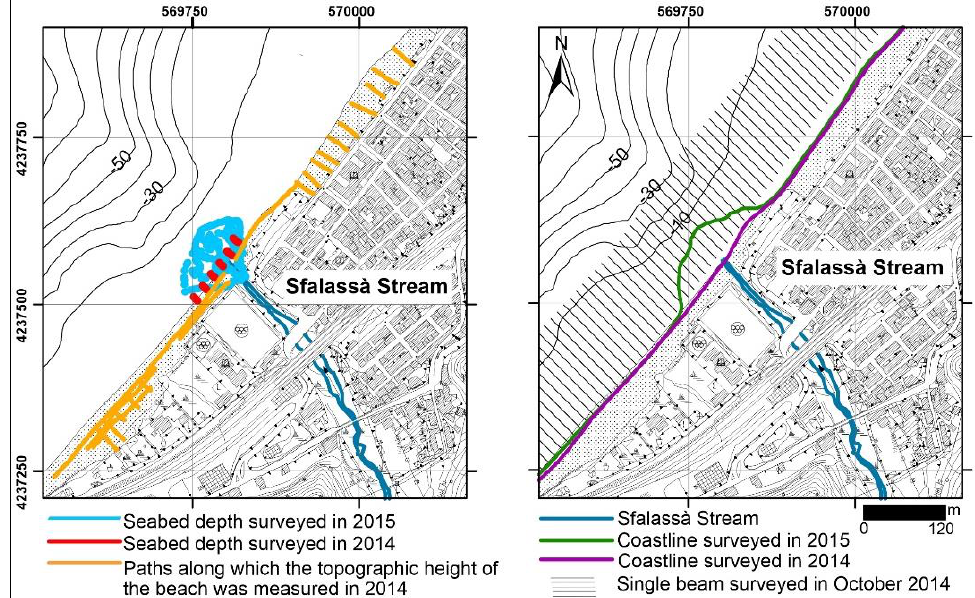
Figure 5. Data surveyed from 2014 to 2015 in the coastal area of Sfalassà mouth. Source: own elaboration draped over the Technical Map of Calabria Region.